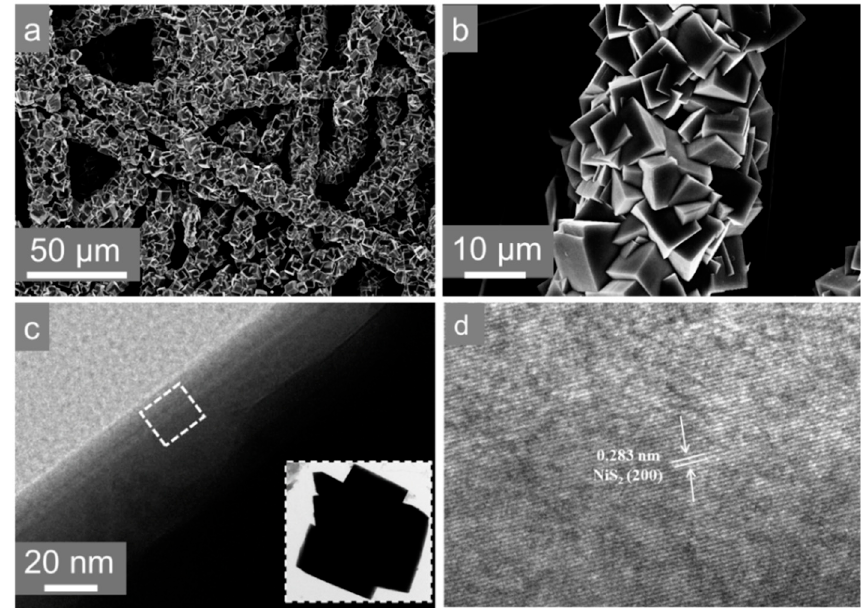
Figure 1. ( a ) and ( b ) Scanning electron microscopy images of NiS 2 ; ( c ) TEM image and ( d ) HRTEM image of NiS 2 . of NiS 2